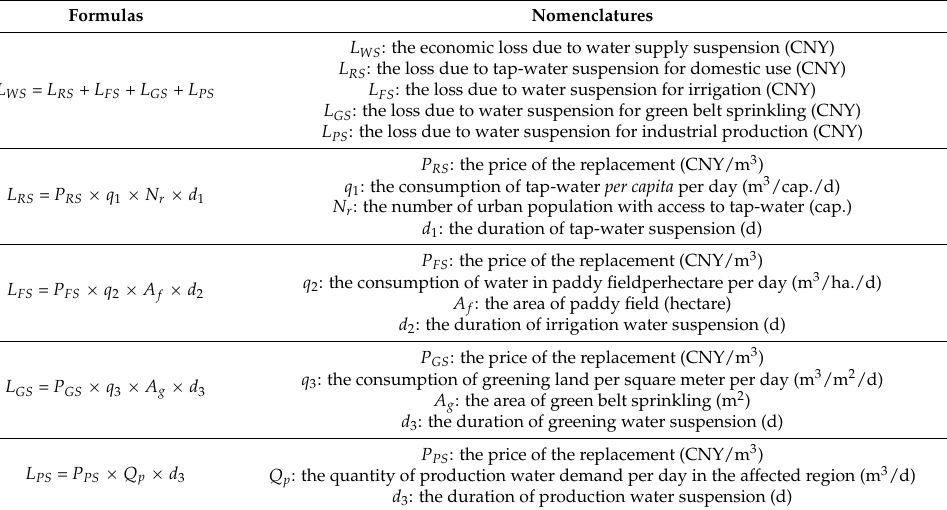
Table 3. The formulas and nomenclature used in the loss estimation of water supply